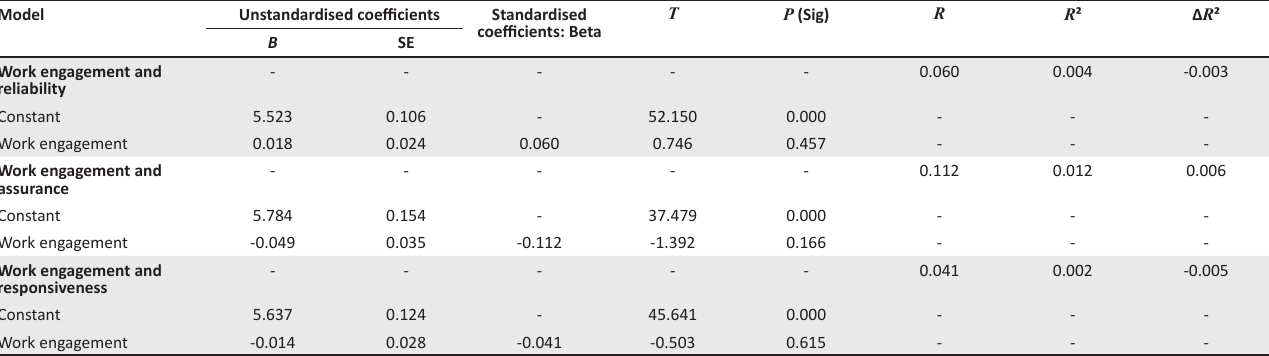
TABLE 6: Regression analyses of work engagement and service